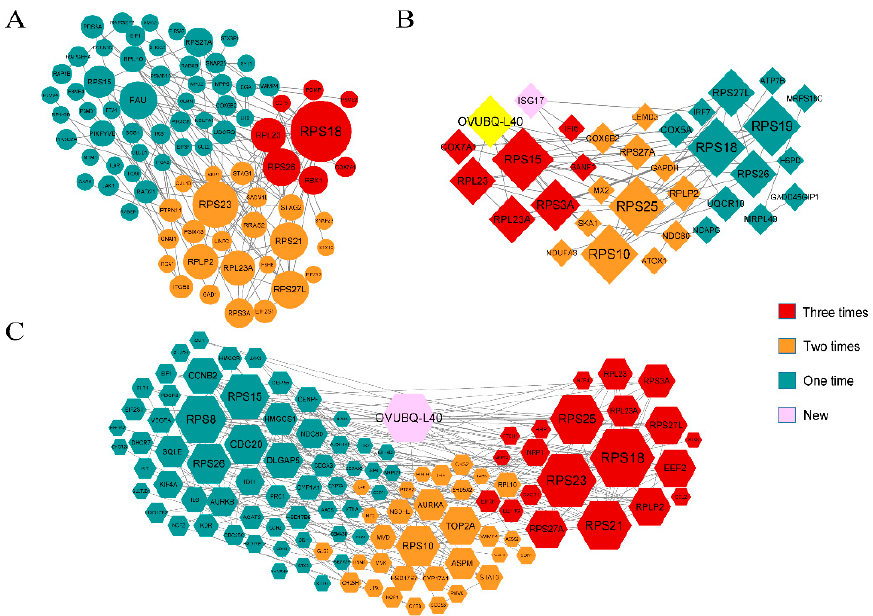
Figure 10. Overview of the protein-protein network related with three tissues ( A ) The interaction network of hypothalamus differential protein with circulars ( B ) The interaction network of pituitary differential protein with diamonds ( C ) The interaction network of ovary differential protein with hexagons. The size of shape indicates Degree. Different colors correspond to the number of participating stages.